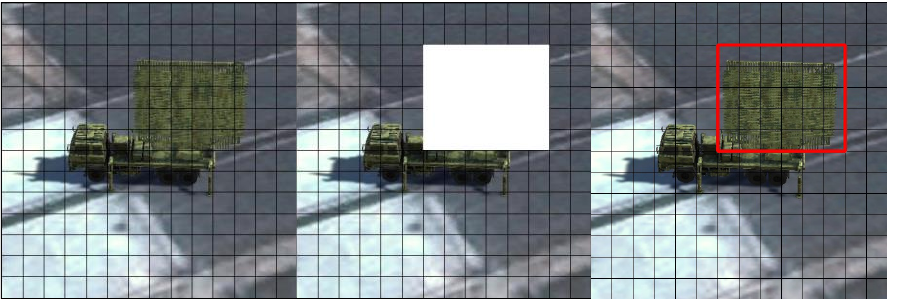
Figure 9. Radar antenna mask.